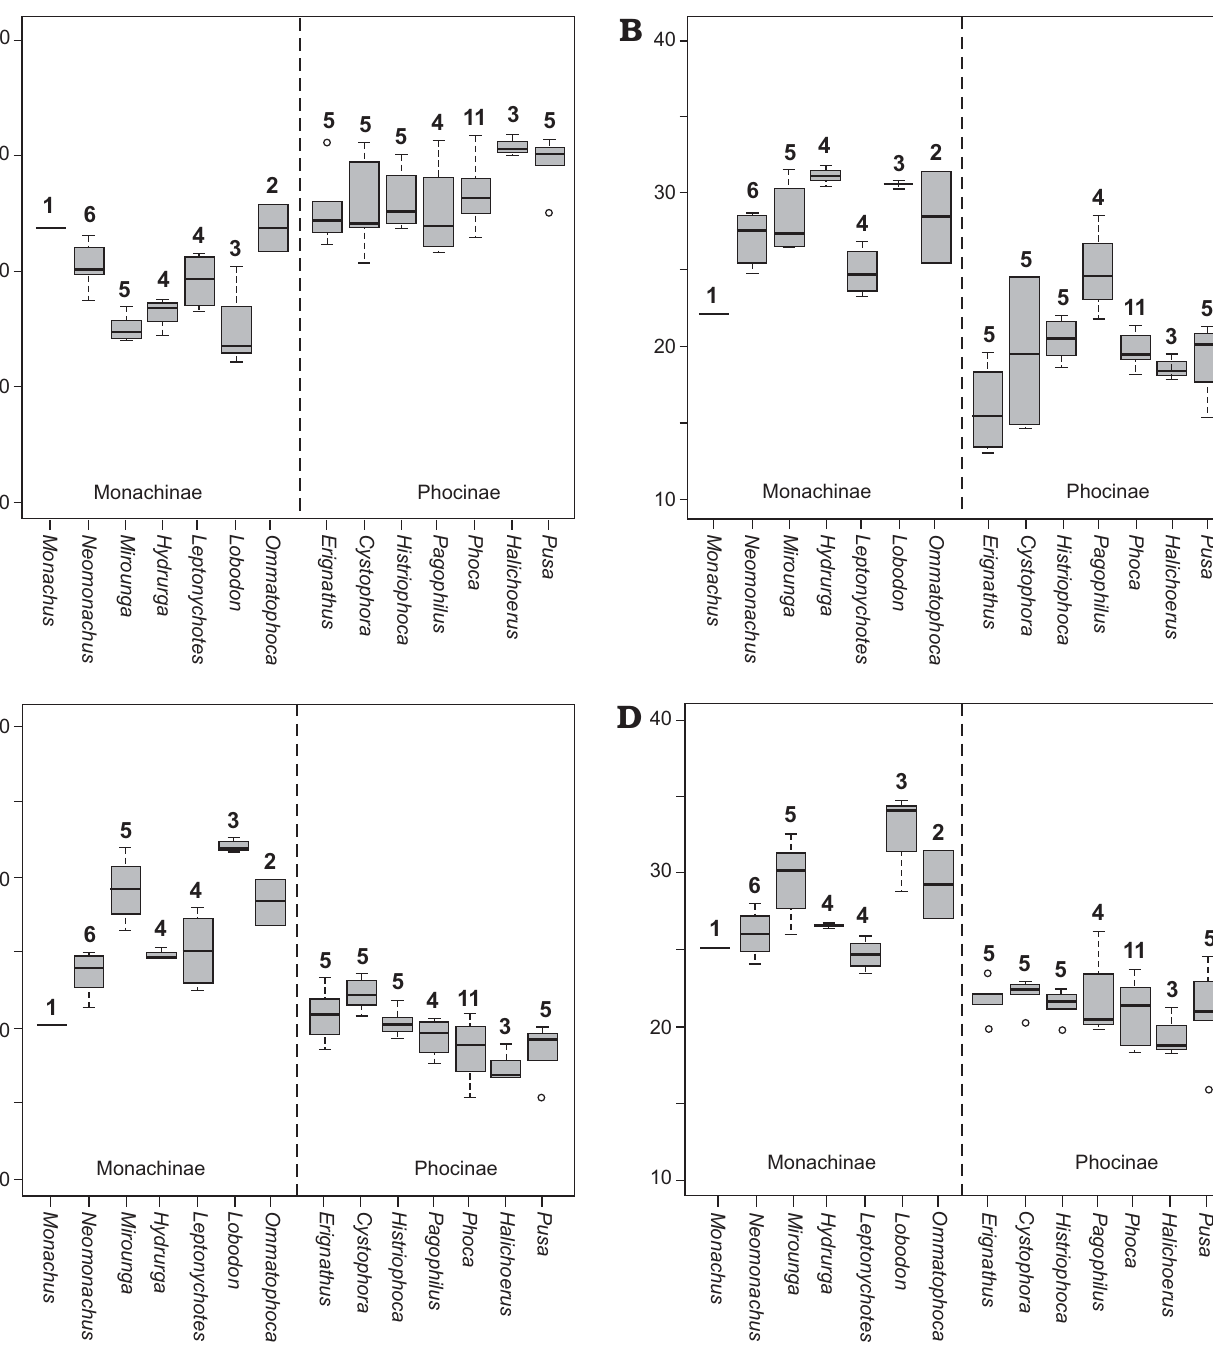
Fig. 6. Boxplots of femoral measurement ratios useful for distinguishing monachine from phocine seal taxa: length of femur medially ( A ), length of medial condyle ( B ), diameter of femur neck ( C ), and width of femur head ( D ) as % of femur length laterally. Subfamilies separated by dashed line. Measurements that fall outside the range of values represented by the upper and lower quartiles indicated by circles. Sample size for each genus listed above the